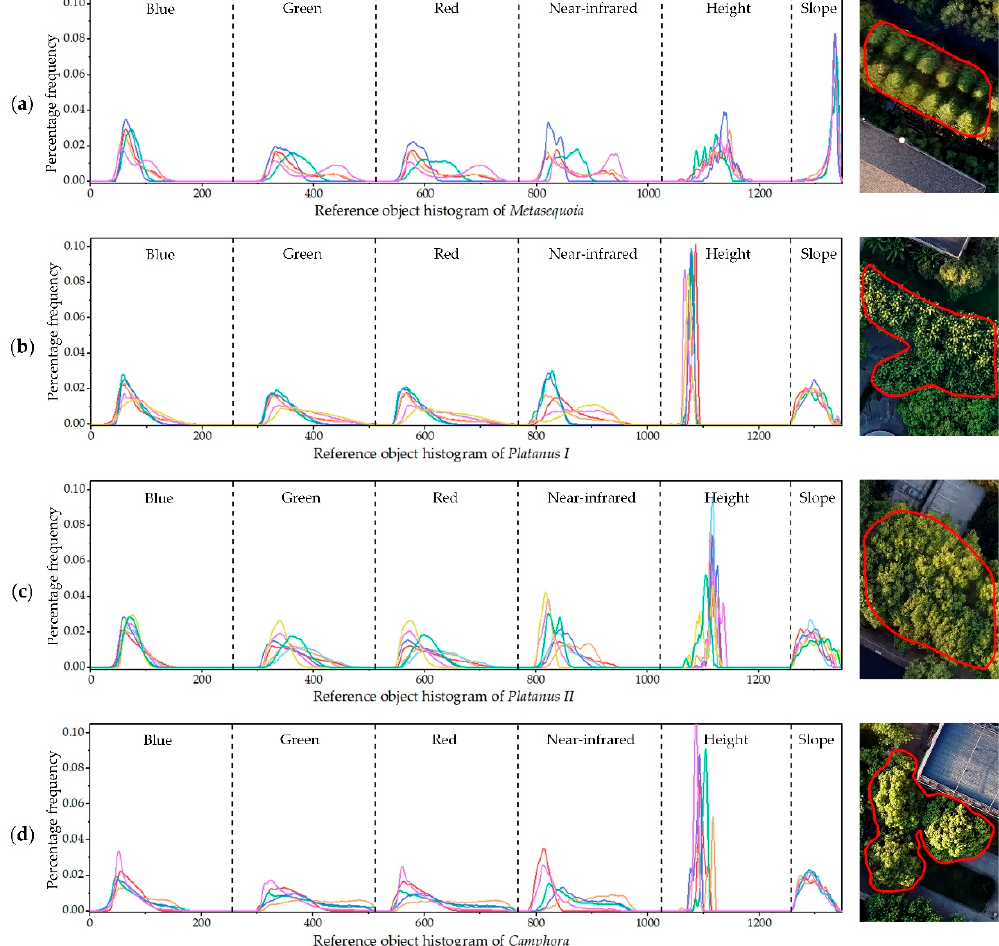
Figure 5. The reference histograms of tree-crown objects for four tree species colored in di ff erent colors. Multiple features are labeled from left to right: spectral features, i.e., blue, green, red and near-infrared features, height feature and slope feature. The numbers of reference object histograms are 5, 6, 7, 5, respectively, for Metasequoia ( a ), Platanus I ( b ), Platanus II ( c ) and Camphora ( d ). Their corresponding UAV images are circled in red on the right.